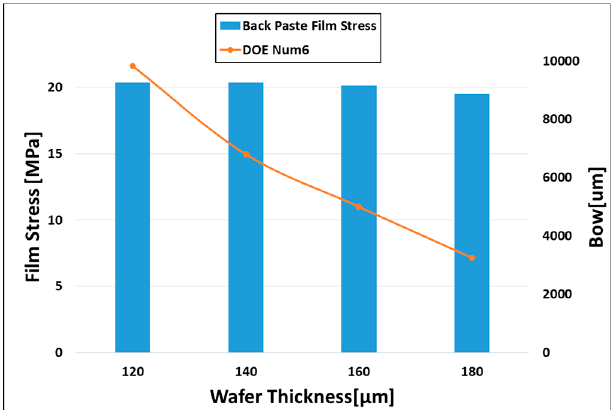
Figure 13. The bowing value and stress value of the back electrode according to change in thickness of the wafer.